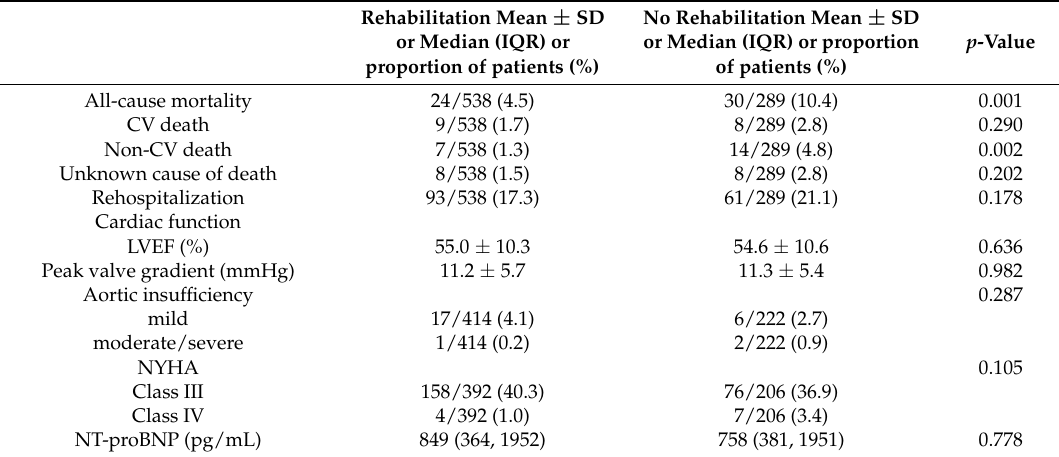
Table 3. Outcomes and cardiac function at six